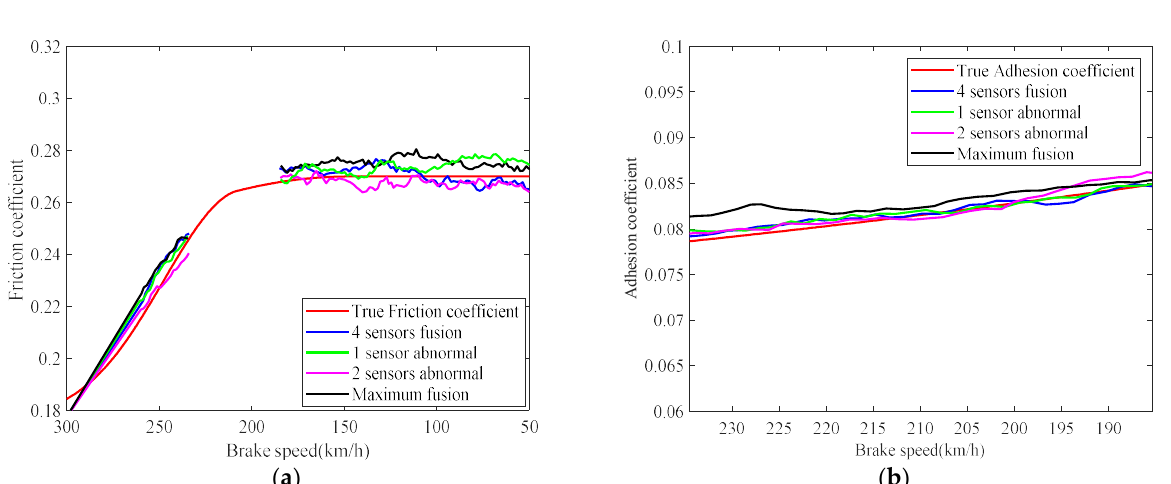
Sensors 2021 , 21 , x FOR PEER REVIEW Figure 20. Identifications of friction coefficient and adhesion coefficient: ( a ) friction coefficient; ( b ) adhesion coefficient.